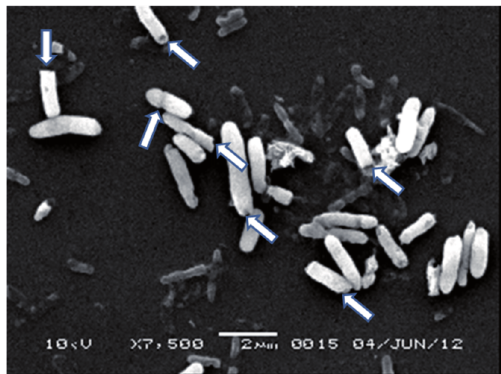
Figure 2: Scanning electron microscope for E. coli BG cells. Arrows show the pores in some of the E. coli BG cells.